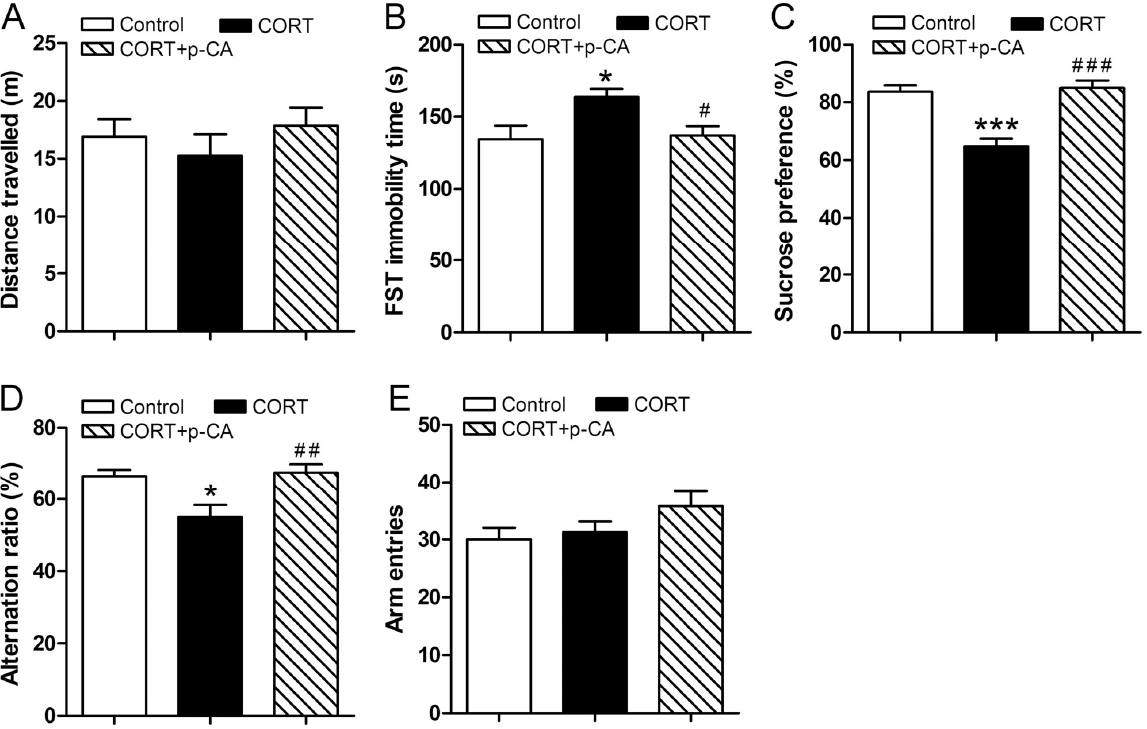
Figure 2. Effect of p-CA treatments on CORT-induced depression-like behaviors and memory impairments. ( A – C ) Depression-like behaviors induced by CORT after p-CA treatments. ( A ) Distance traveled in LMA ( n = 10). ( B ) Immobility time in the FST ( n = 10). ( C ) Sucrose preference in SPT ( n = 5). ( D , E ) Memory impairments in Y-maze induced by CORT after p-CA treatments. ( D ) Alteration ratio and (E) arm entries in Y-maze ( n = 10). * p < 0.05, *** p < 0.001,vs. control group, ### p < 0.001, ## p < 0.01, # p < 0.05, vs. CORT group. CORT, corticosterone; FST, forced swimming test; LMA, loco- motor activity; p-CA, p-coumaric acid; SPT, sucrose preference test.